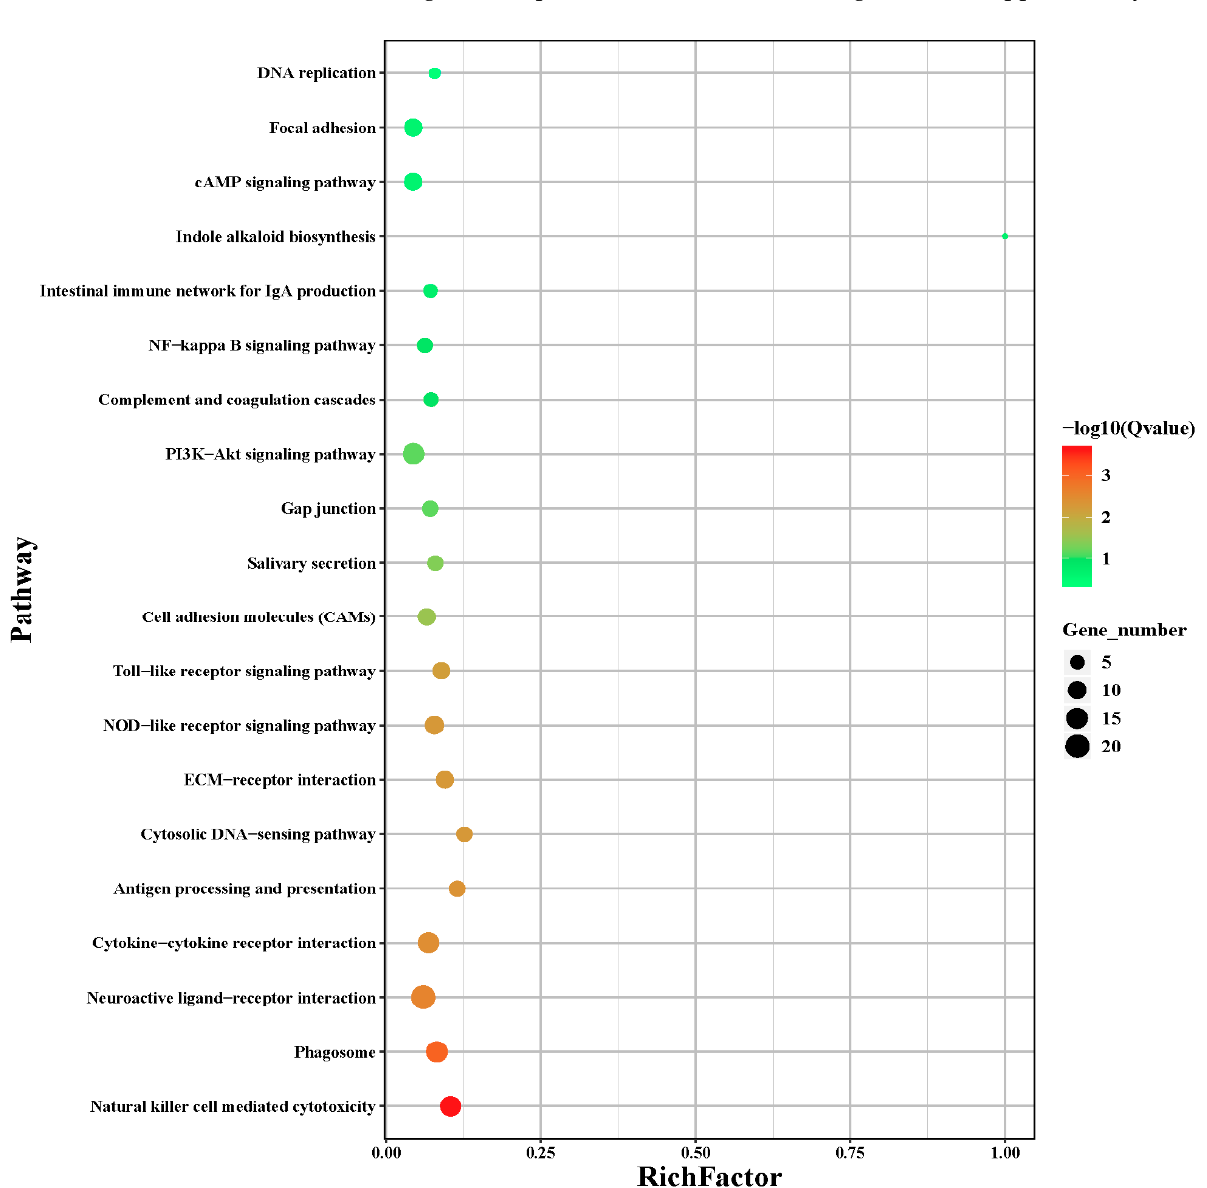
Figure 3. KEGG pathway enrichment analysis. Differentially expressed genes in spleen. y-Axis represents enriched pathways; x-axis represents the rich factor of pathways. Bubble size represents the number of genes, and the color bar represents